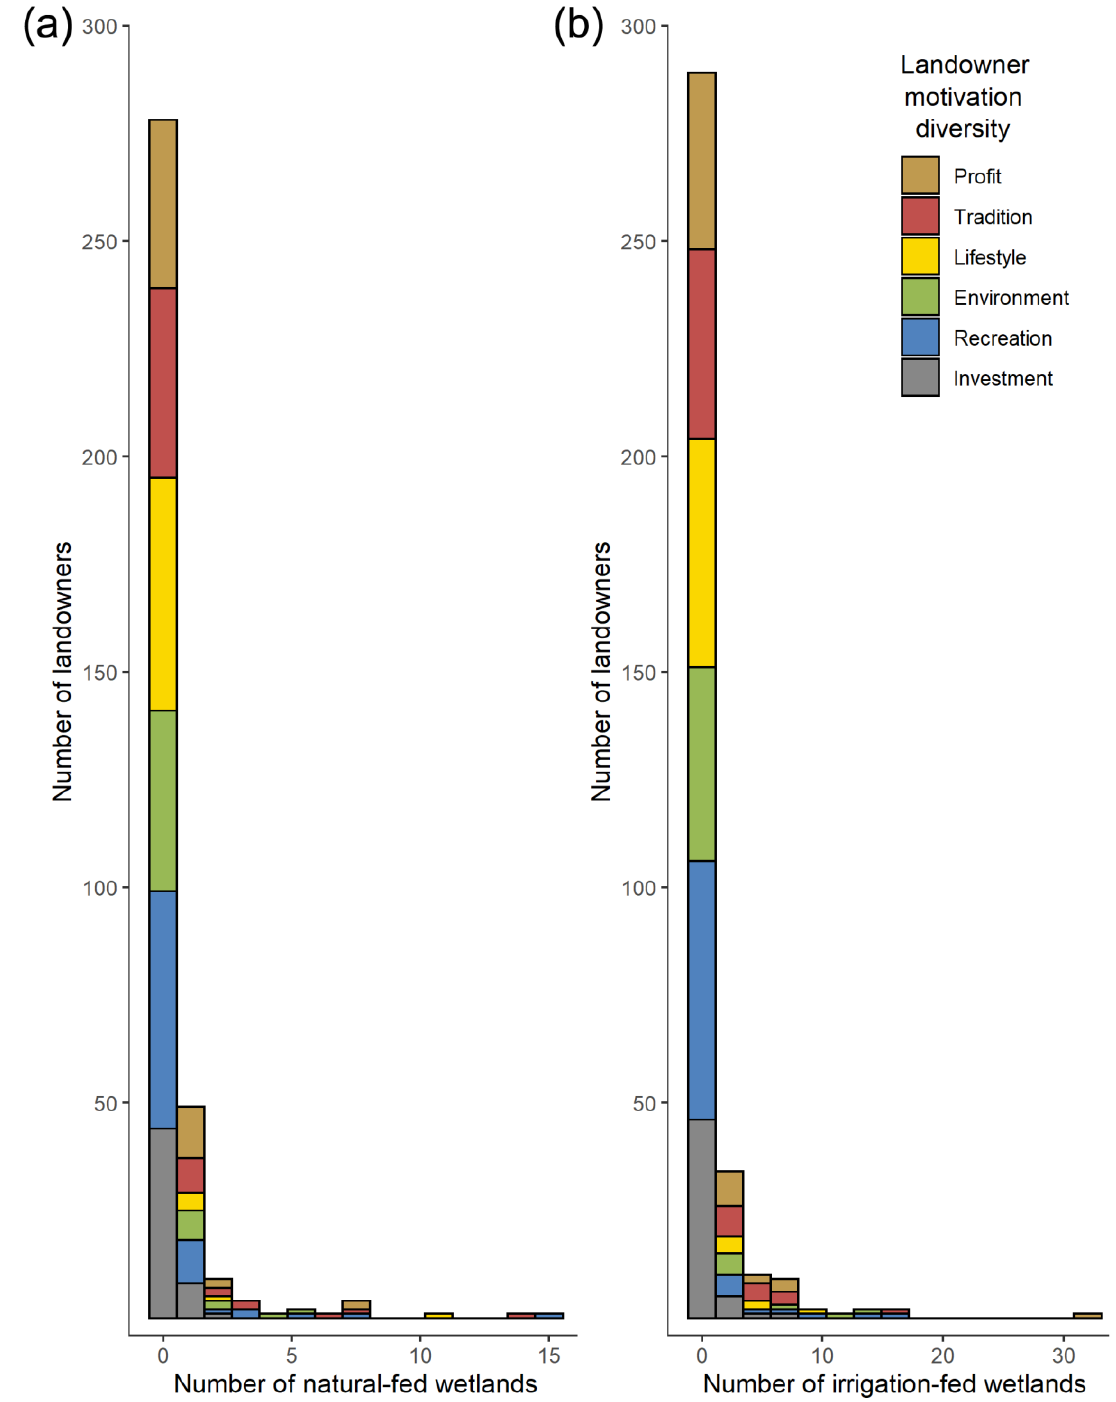
Figure A1.2. Histograms (15 bins) of the number of (a) natural-fed wetlands and (b) irrigation- fed wetlands on n = 351 landowner respondents’ properties. One outlier recreation-motivated landowner with 138 irrigation-fed wetlands was excluded from panel